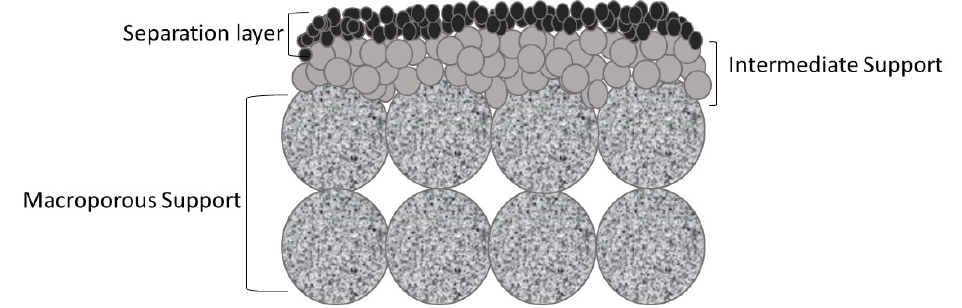
Figure 1. Scheme of ceramic membrane layers. Adapted from [15]. Reprinted with permission from ref. [15]. Copyright 2021